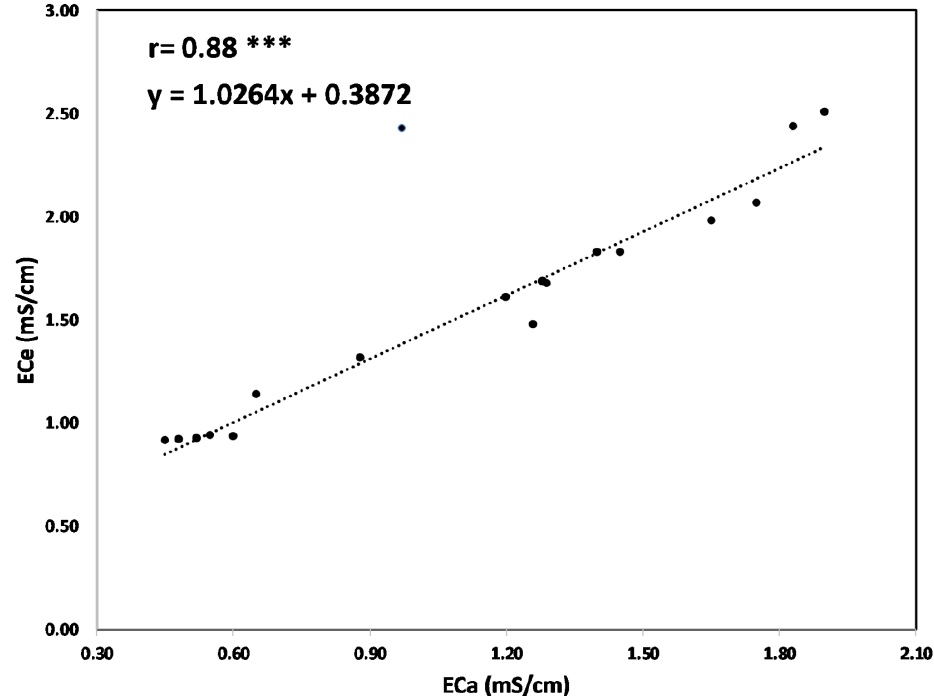
Figure 10. ECe vs. ECa correlation function. The number of points of the fitting curve is 18. Statistically significant at p -value significance level: * 0.05, ** 0.01, *** 0.001 levels of significance.